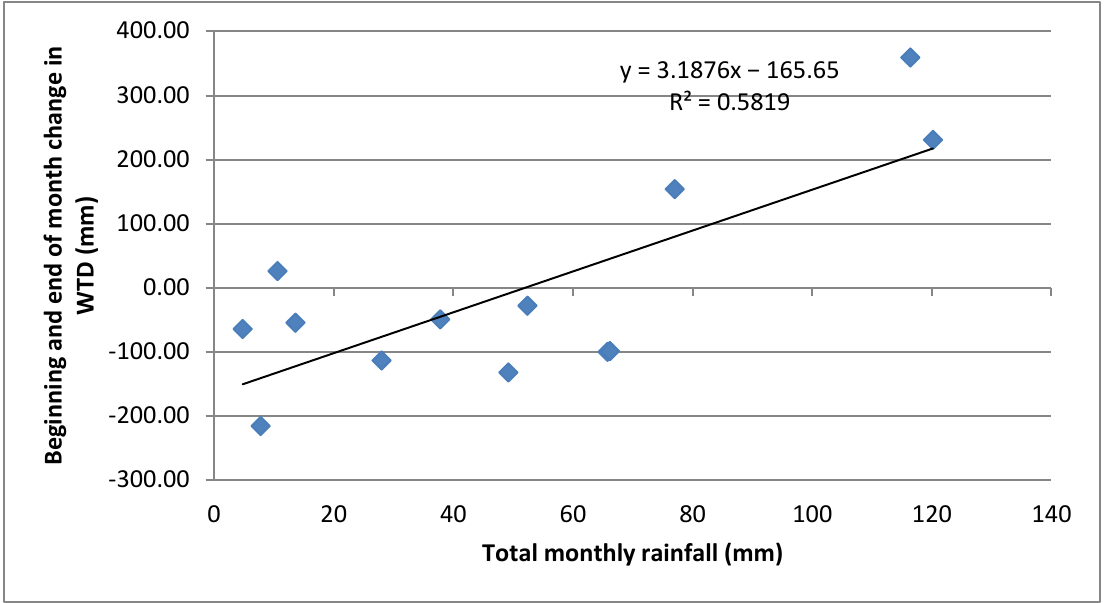
y = 3.1876x − 165.65 R² = 0.5819